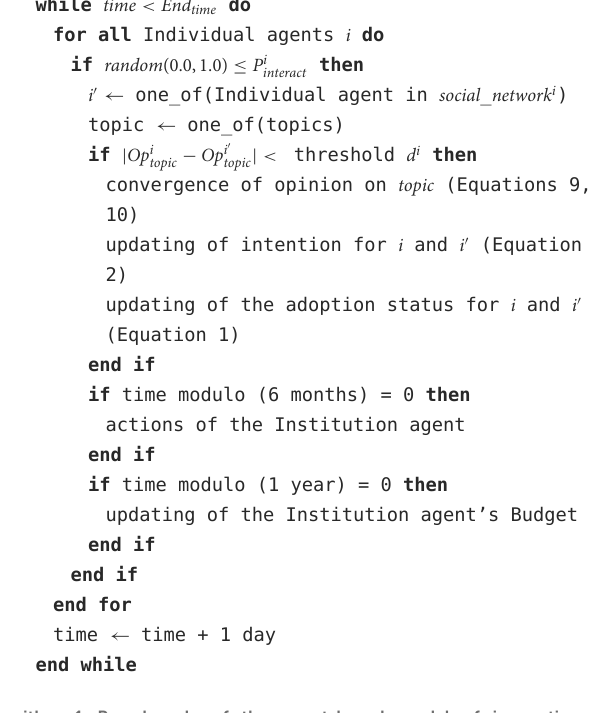
Algorithm 1. Pseudocode of the agent-based model of innovation